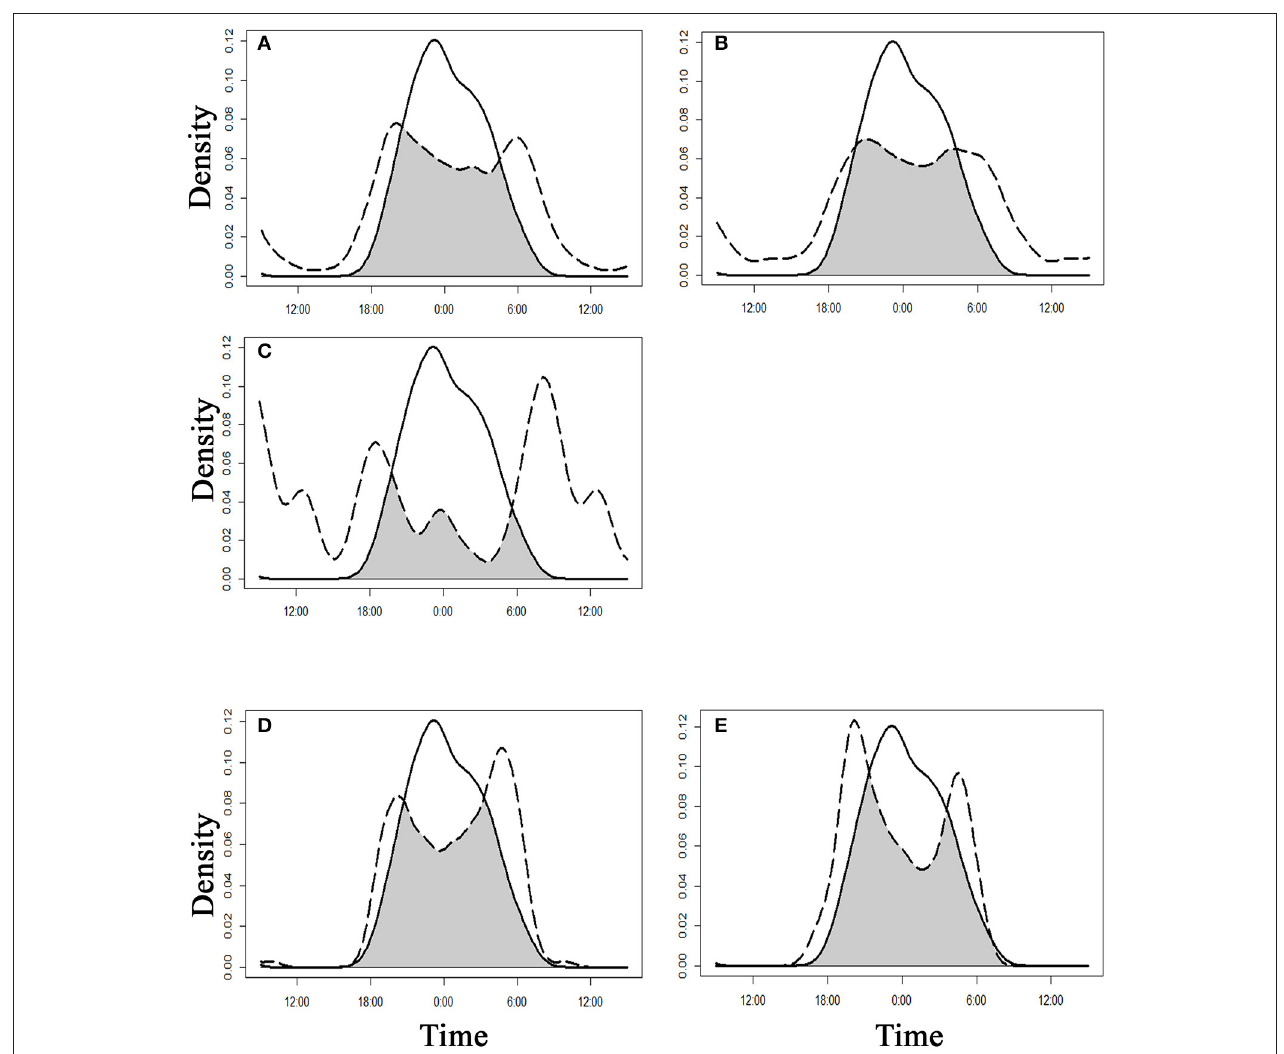
FIGURE 4 | Overlap of activity patterns between sympatric carnivores in Tadoba-Andhari Tiger Reserve (TATR), central India, calculated using a kernel-density function. The activity overlap between paired predators is depicted in gray. The solid line represents the activity pattern of honey badger and the dotted line represents the activity of other carnivores. (A) tiger and honey badger, (B) leopard and honey badger, (C) dhole and honey badger, (D) jungle cat and honey badger, (E) rusty-spotted cat and honey